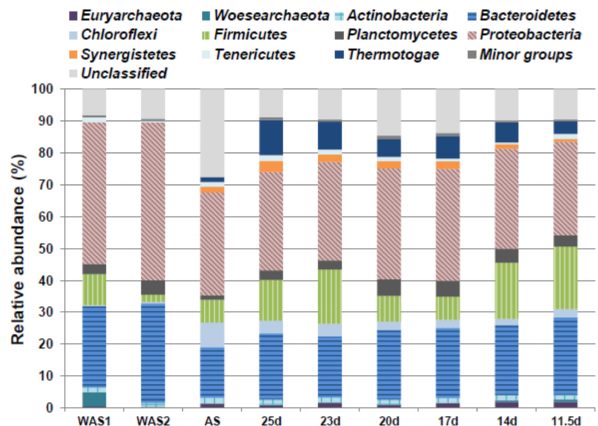
Figure 3. Relative abundance of the identified taxa in the samples at the phylum level. Taxa < 1% at all samples are collectively shown as ‘minor